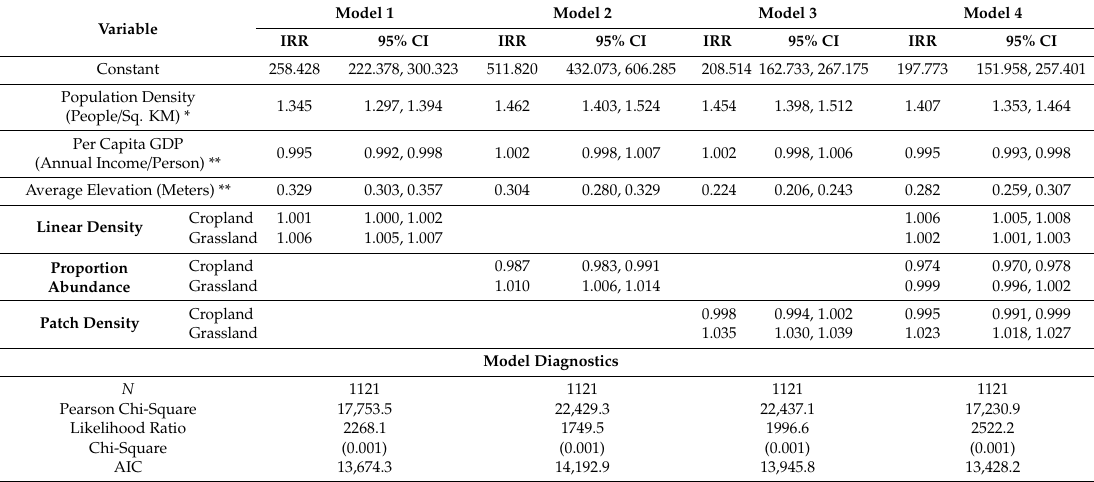
Table 3. Negative binomial regression results for ZIKV.